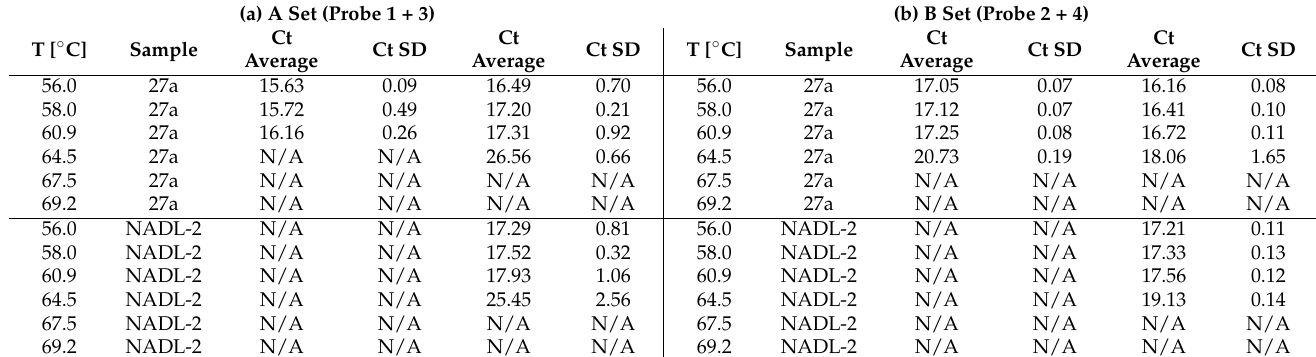
Table 2. Sensitivity of the dual qPCR using 27a ( a ) and non-27a (K22) ( b ) DNA. One µ L of